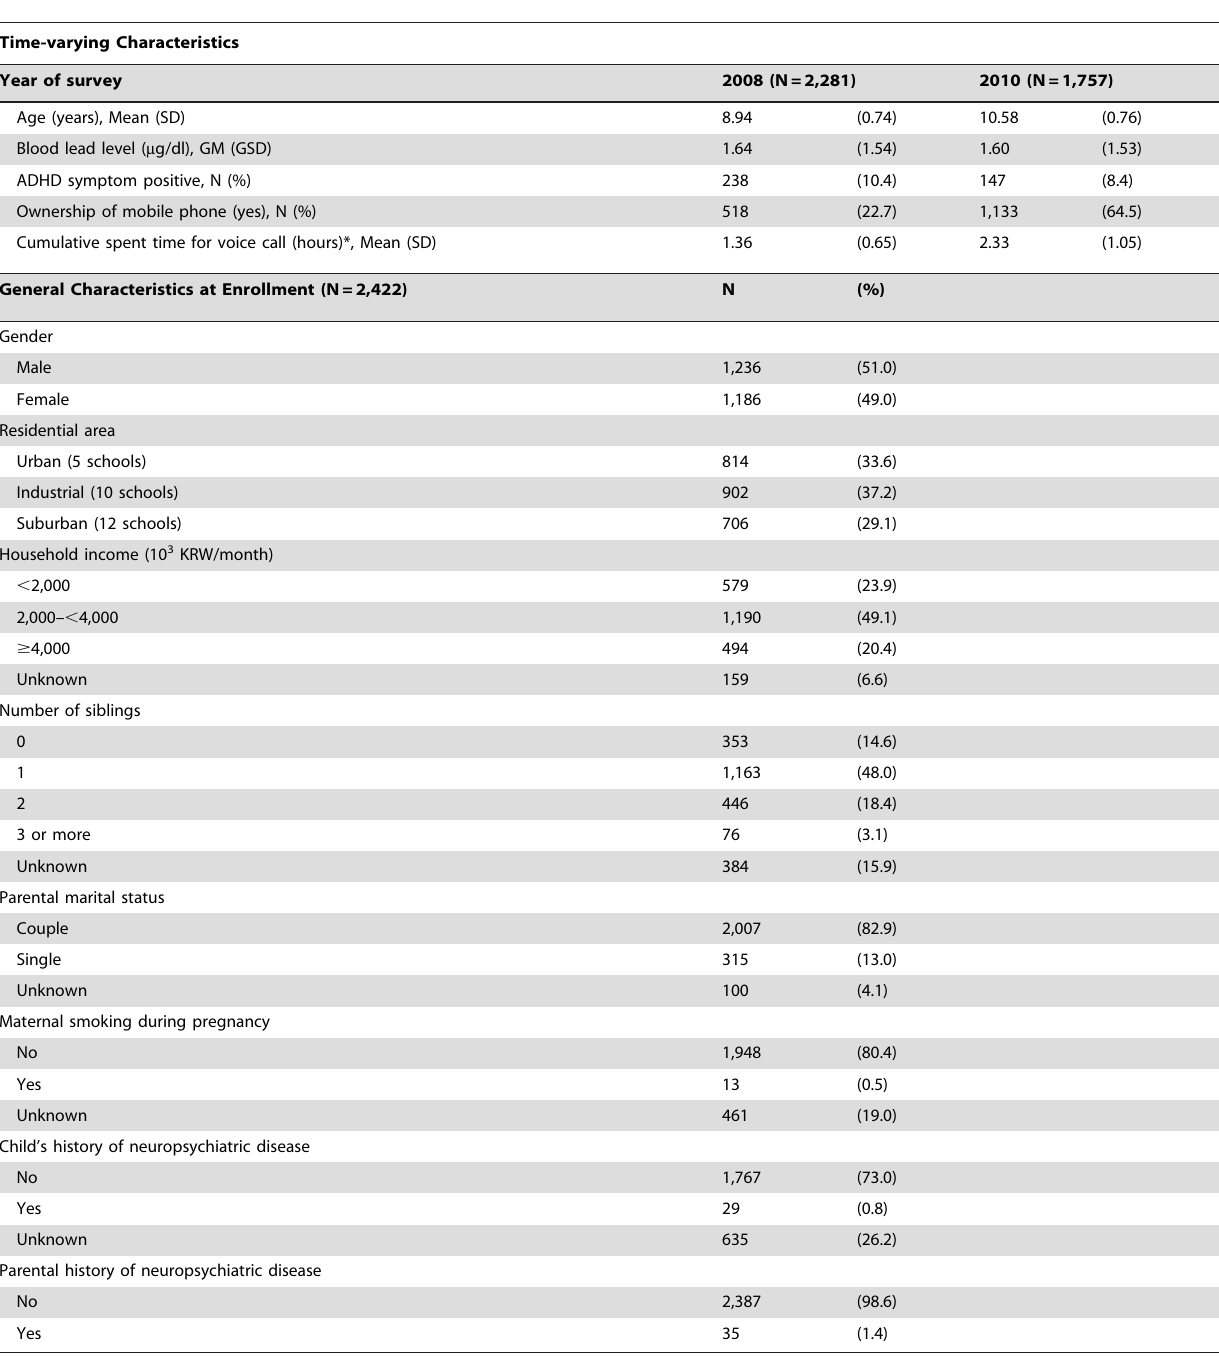
Table 1. Characteristics and Mobile Phone Use Patterns of Children in 2008 to 2010, Korea, the CHEER study.